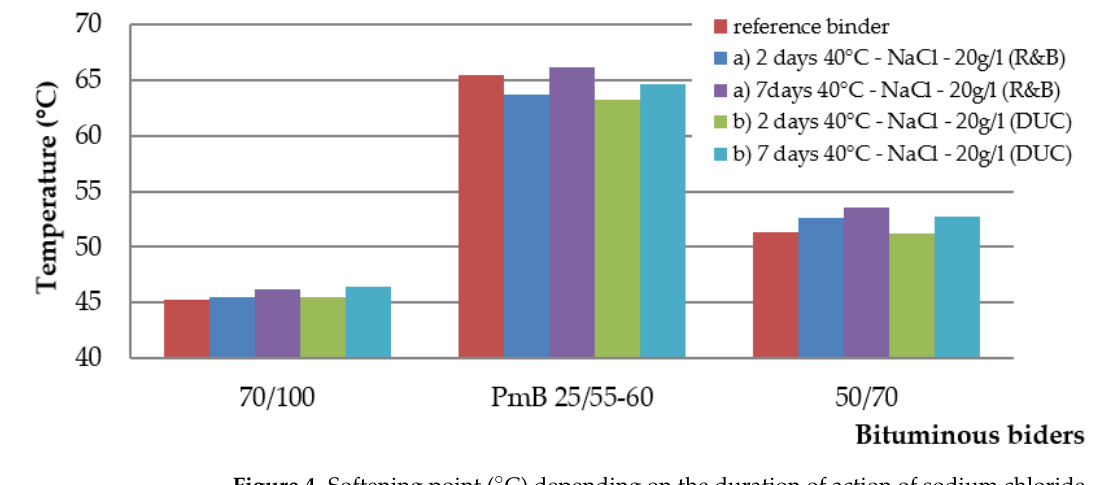
Figure 3. Penetration value (0.1 mm) depending on the duration of action of sodium chloride.